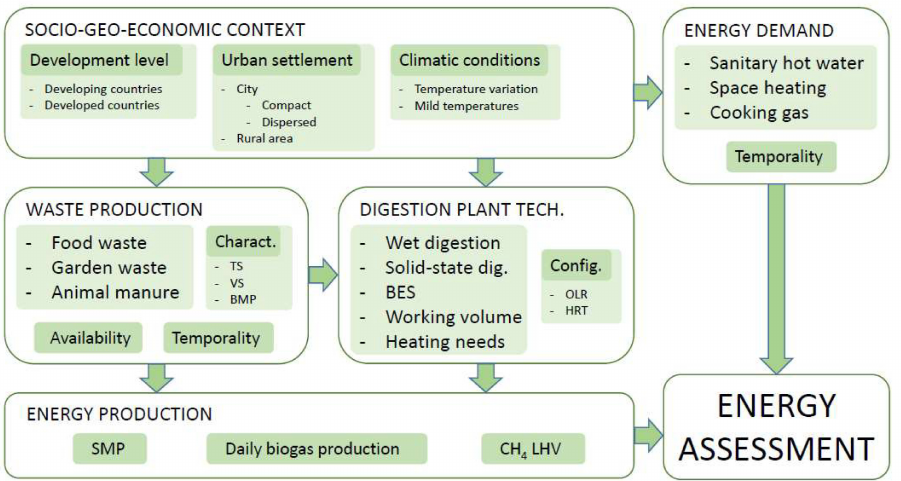
Figure 1. Schematization of methodology for estimating biogas and energy production from the different scenarios considered. TS: total solids, VS: volatile solids, BMP: biochemical methane potential, BES: bioelectrochemical systems, OLR: organic loading rate, HRT: hydraulic retention time, SMP: specific methane production, LHV: lower heating